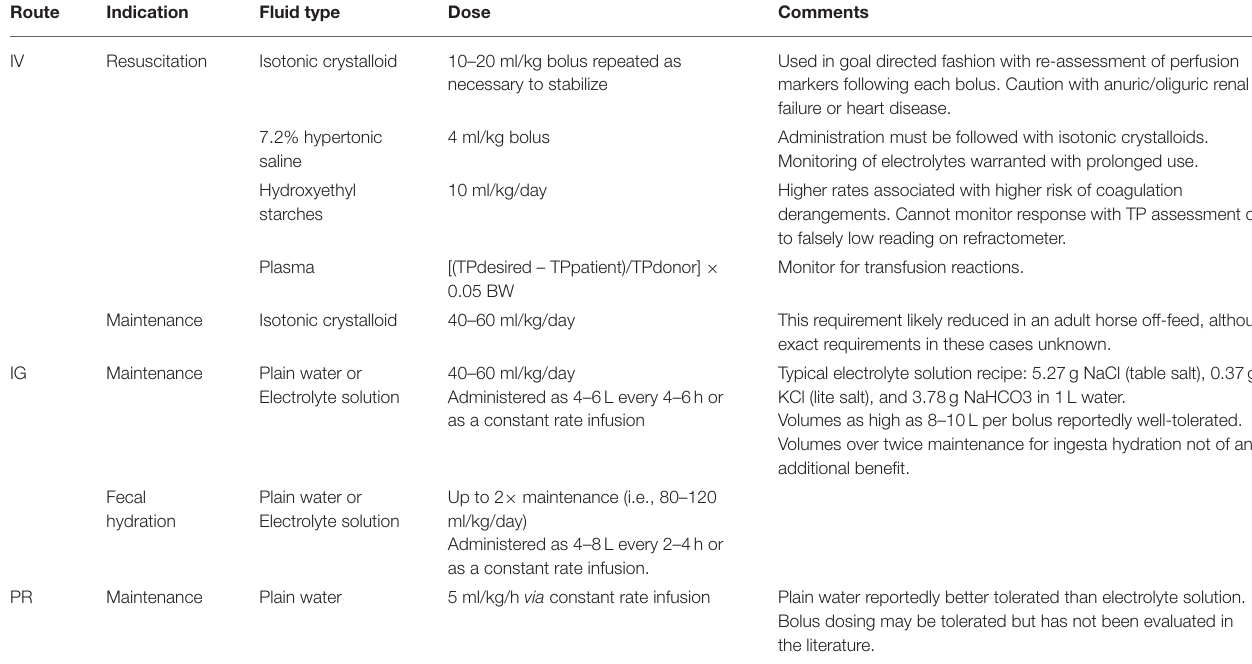
TABLE 2 | Fluid therapy dosing recommendations for adult